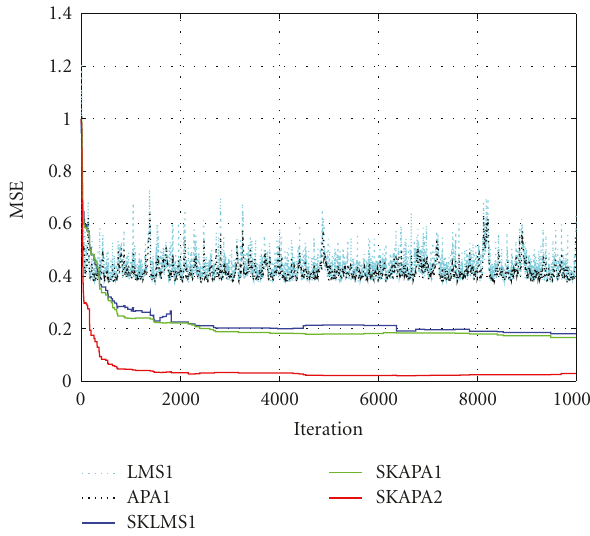
Figure 6: The learning curves of the LMS1, APA1, SKLMS1, SKAPA1, and SKAPA2 in the nonlinear channel equalization ( σ = 0 . 1).